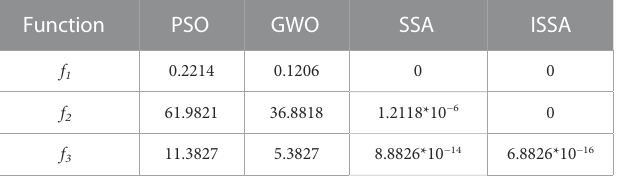
TABLE 2 Performance comparison of each algorithm.